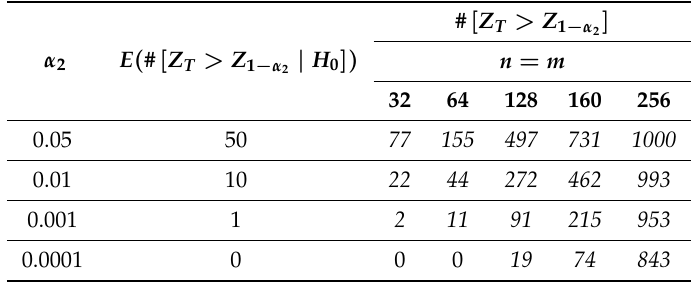
Table 11. Expected E ( # [ Z T > Z 1 − α repetitions of the BIC test in SAC matrices generated with the RC4. All cases in which the observed number of rejections exceeds the expected value are indicated in italics.